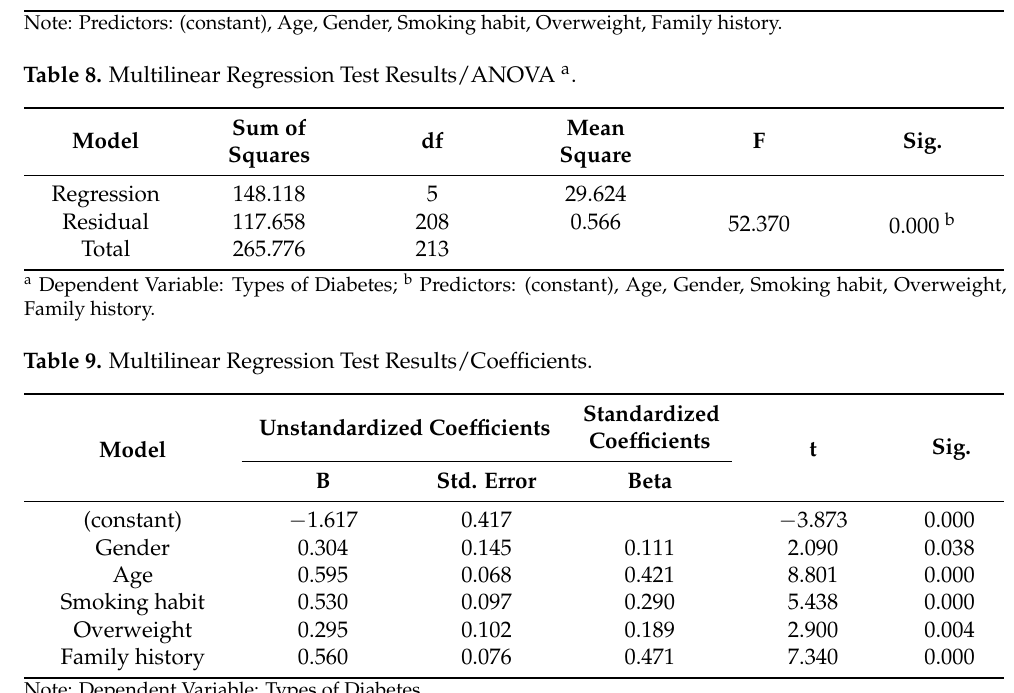
Table 7. Multilinear Regression Test Results/Model Summary. Model